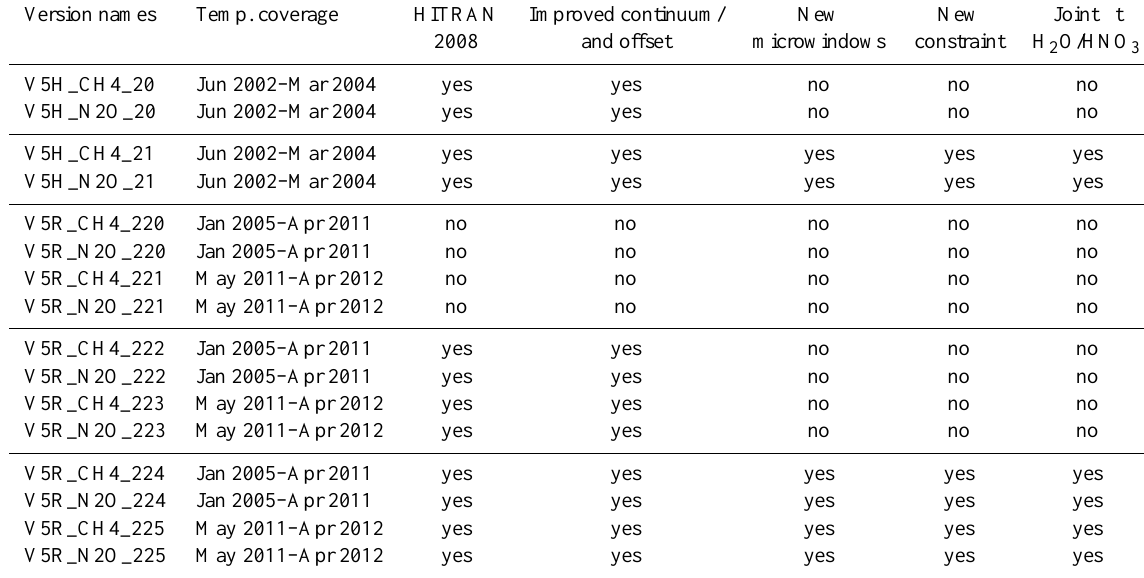
Table 1. Data versions with temporal coverage and information for which the changes discussed in Sect. 3 were applied. Version names Temp.